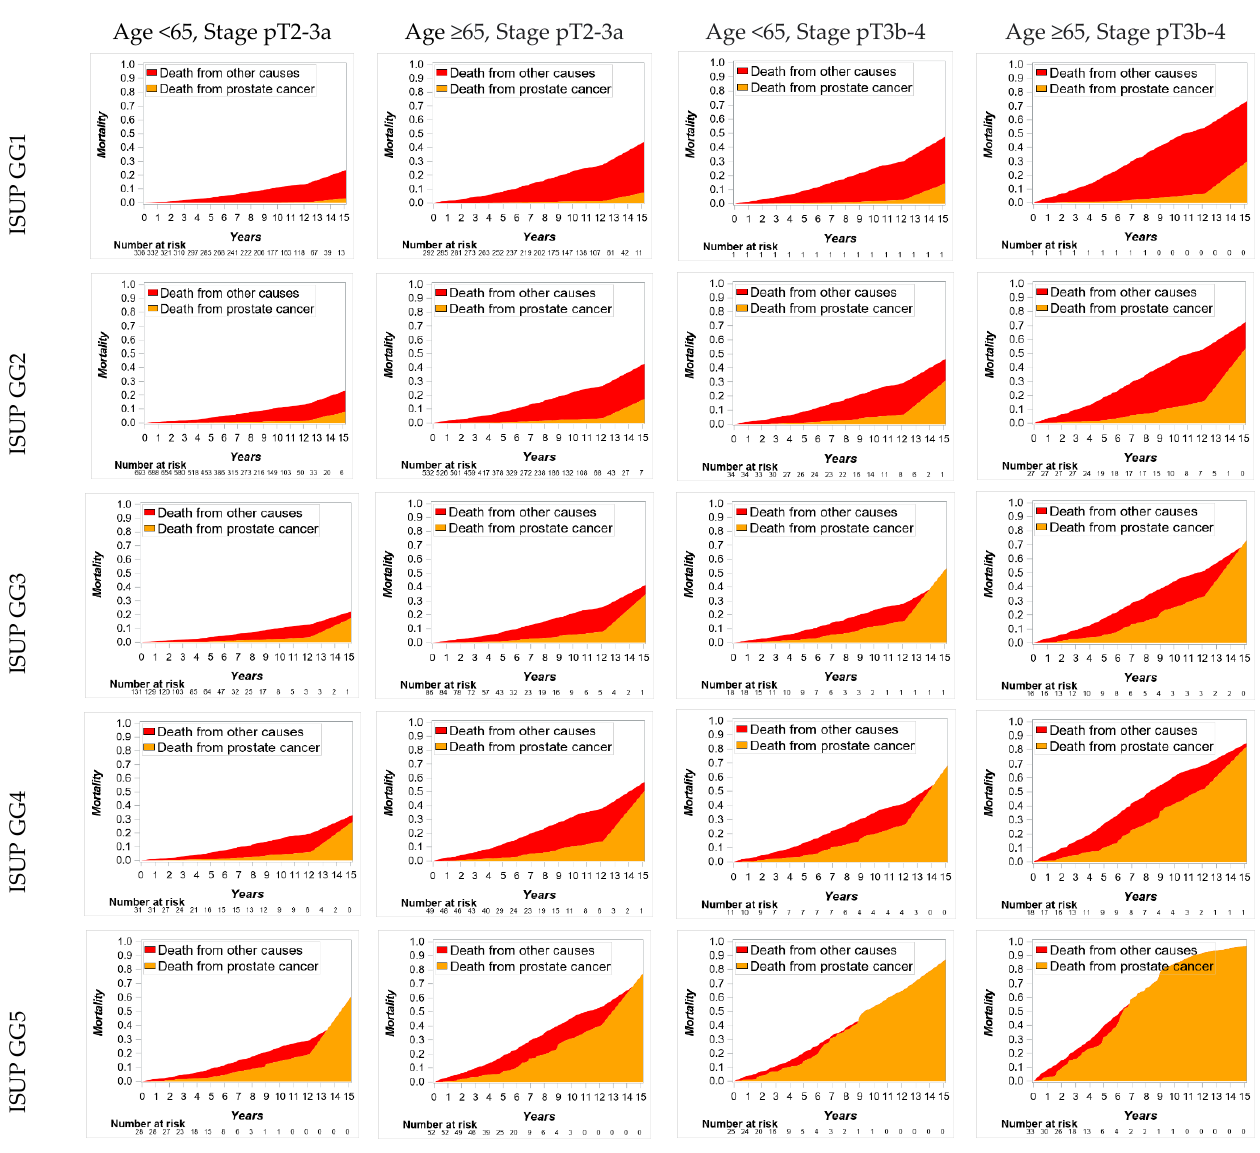
Figure 1. Cumulative cancer-specific and other-cause mortality in groups stratified by patient age (<65 vs. ≥ 65), pathological stage (pT2-3a vs. pT3b-4), and postoperative International Society of Urological Pathology Grade Group (ISUP GG).